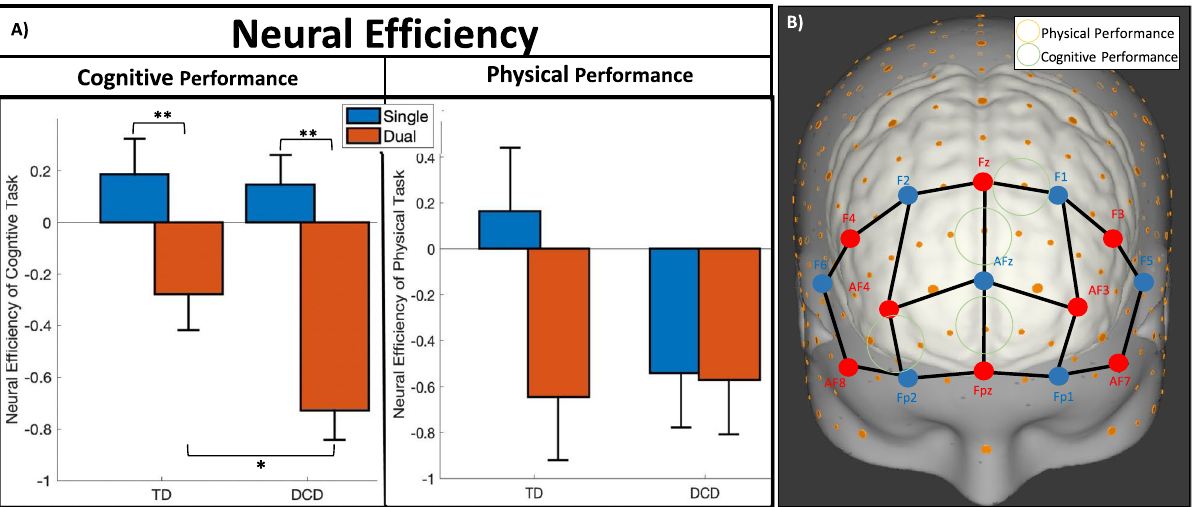
Figure 3. ( A ) Example patterns of Neurobehavioral (Neural Efficiency) results per group and task (* p < 0.05, ** p < 0.01, *** p < 0.001) with error bars representing standard error of the mean. Cognitive Performance example pattern is from optode 9, while Physical Performance example pattern is from optode 13. ( B ) Significant regions of the Neural Efficiency patterns found in A, where green circles indicate significant patterns for the NE of Cognitive Performance, while the yellow circles indicate significant patterns for the NE of Physical Performance. There are no regions of significant interaction effect of group and task for NE of